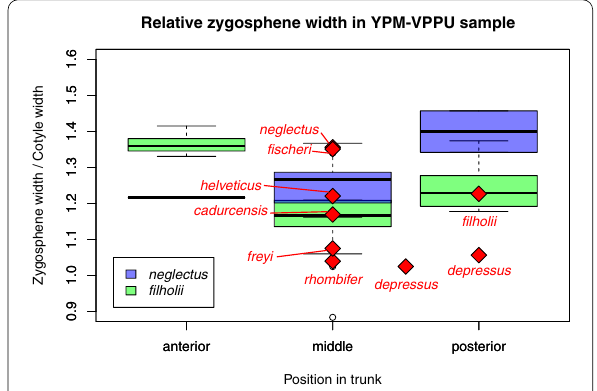
Fig. 47 Neural spine length ratio in YPM populations of “ Palaeopython ” neglectus and Phosphoroboa filholii comb. nov. compared to same ratio in type material of various Paleogene constrictors from Europe. There is no overlap between the two YPM populations. That Palaeopython cadurcensis and “ Palaeopython ” neglectus are virtually identical is remarkable considering that the neural spine extends far out onto the zygosphenal tectum in the latter “mummy”